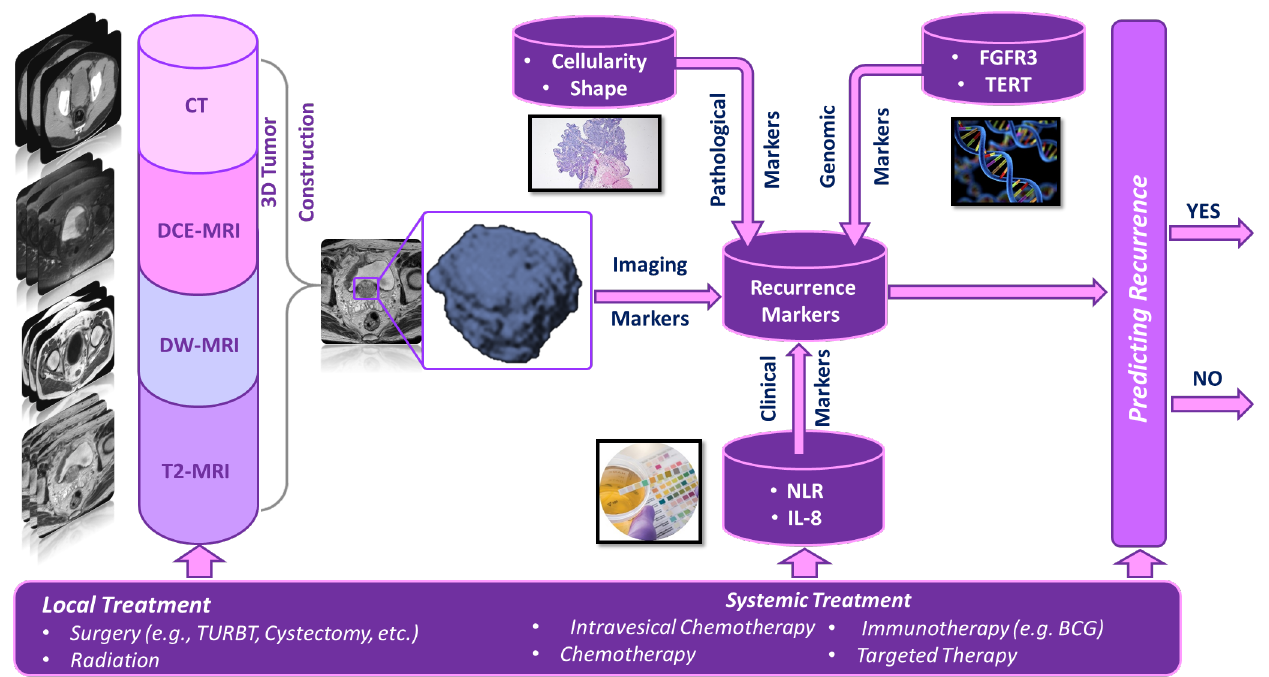
Figure 1. A typical pipeline for a computer-aided prediction (CAP) system that can predict the recurrence of bladder cancer at an early stage.